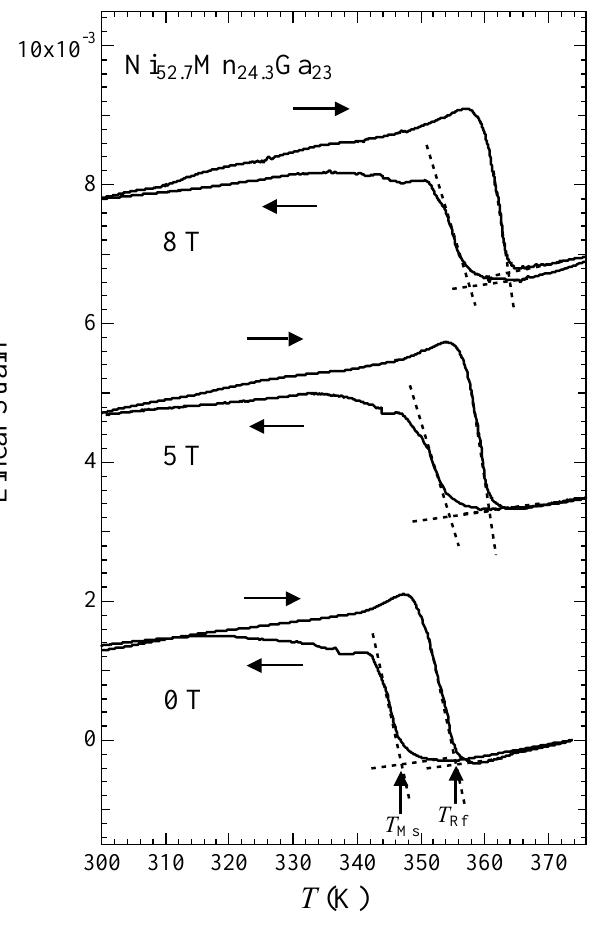
Figure 8. Temperature dependence of the linear thermal strain of Ni magnetic fields, parallel to the longitudinal direction of the